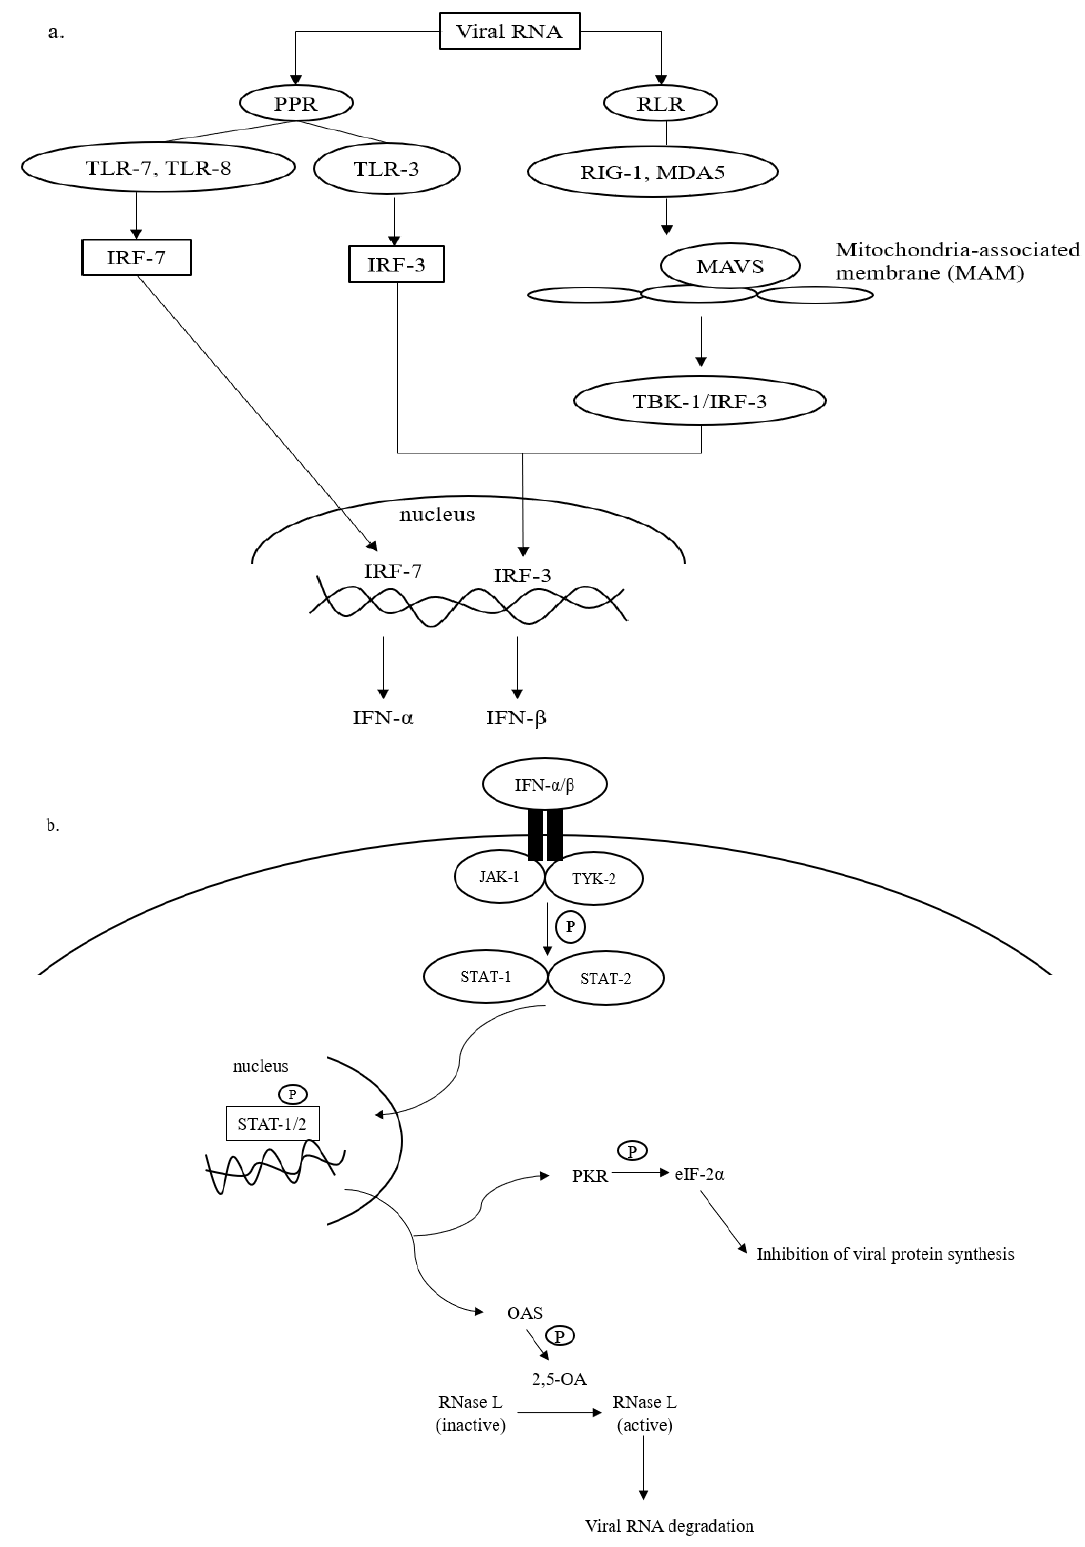
Figure 1. Antiviral defense of IFN. ( a ) Viral RNA (vRNA) can be recognized by pathogen pattern receptors (PPR) on the cell surface and retinoic acid-like receptors (RLR) in the cytosol. The vRNA sensing by PPR can be initiated by toll-like receptors (TLR)-3, -7, and -8, which then activates gene transcription factors, i.e., interferon regulatory factors (IRF)-3 and -7. IRF-3 and -7 are then translo- cated into the cell nucleus to express interferon (IFN)- β and interferon- α , respectively. The cytosolic viral dsRNA, on the other hand, is recognized by retinoic-like receptors (RLR) such as retinoic acid- inducible gene-1 (RIG-I) and melanoma di ff erentiation-associated protein 5 (MDA-5). The RLR/vRNA complex subsequently binds to the mitochondrial-antiviral signaling (MAVS) protein located on the mitochondrial outer membrane. Upon the activation of MAVS, IRF-3 is phosphory- lated via TANK-binding kinase (TBK)-1 to enhance the expression of IFN- β . ( b ) The antiviral cas- cades of IFN α / β demand the activation of Janus kinase/tyrosine kinase/signal transducer and acti- vator of transcription (JAK/TYK/STAT) signaling. Activating the JAK/TYK/STAT transcription sig- naling pathway results in the expression of antiviral proteins, oligoadenylate synthetase (OAS), and protein kinase R (PKR), which are responsible for viral RNA degradation and inhibition of viral protein synthesis, respectively.